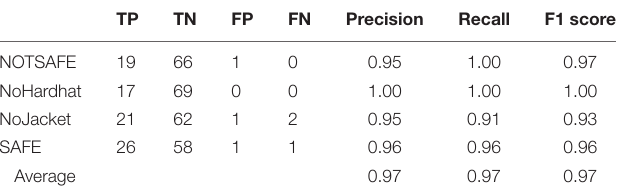
TABLE 5 | Classification report for the test dataset.